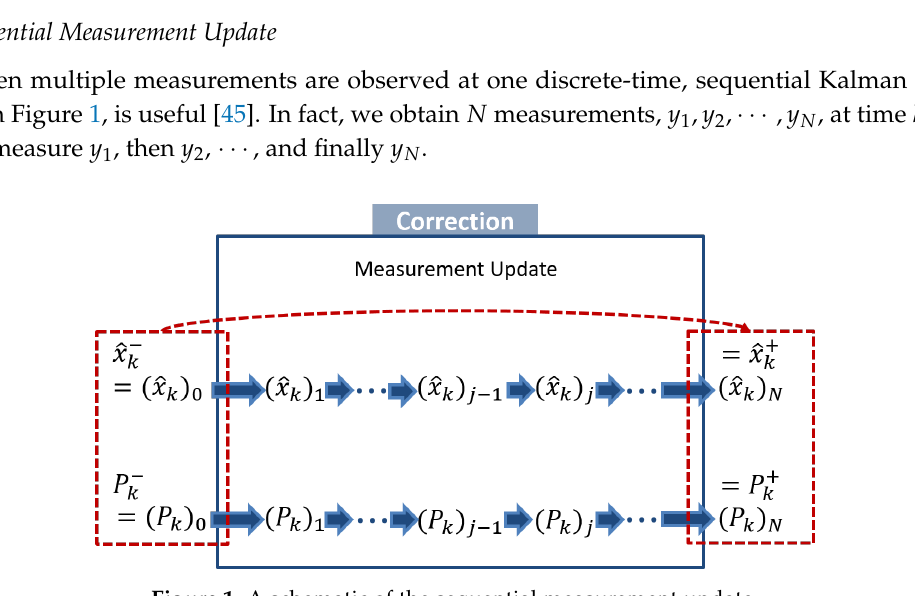
Figure 1. A schematic of the sequential measurement